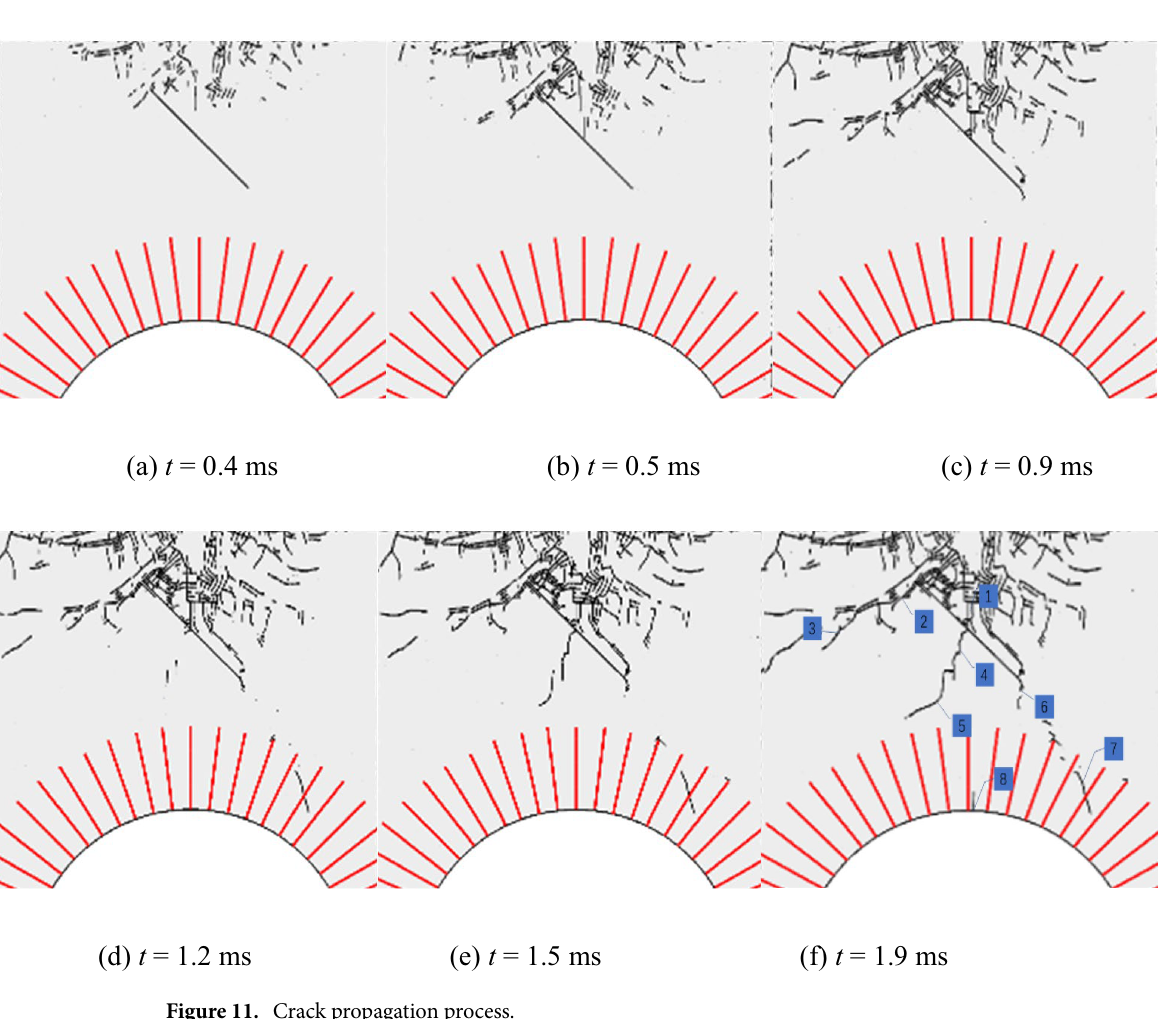
Figure 11. Crack propagation